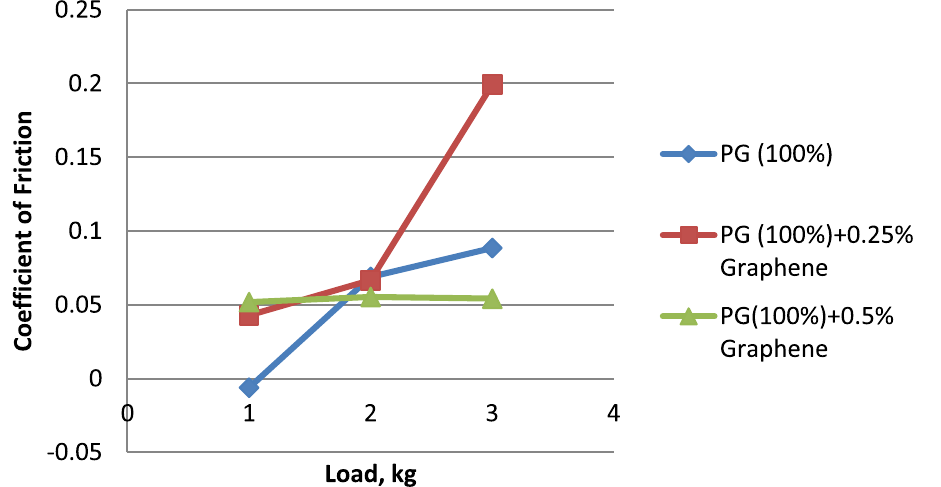
Figure 7. Load vs. coefficient of friction for propylene glycol (100%).